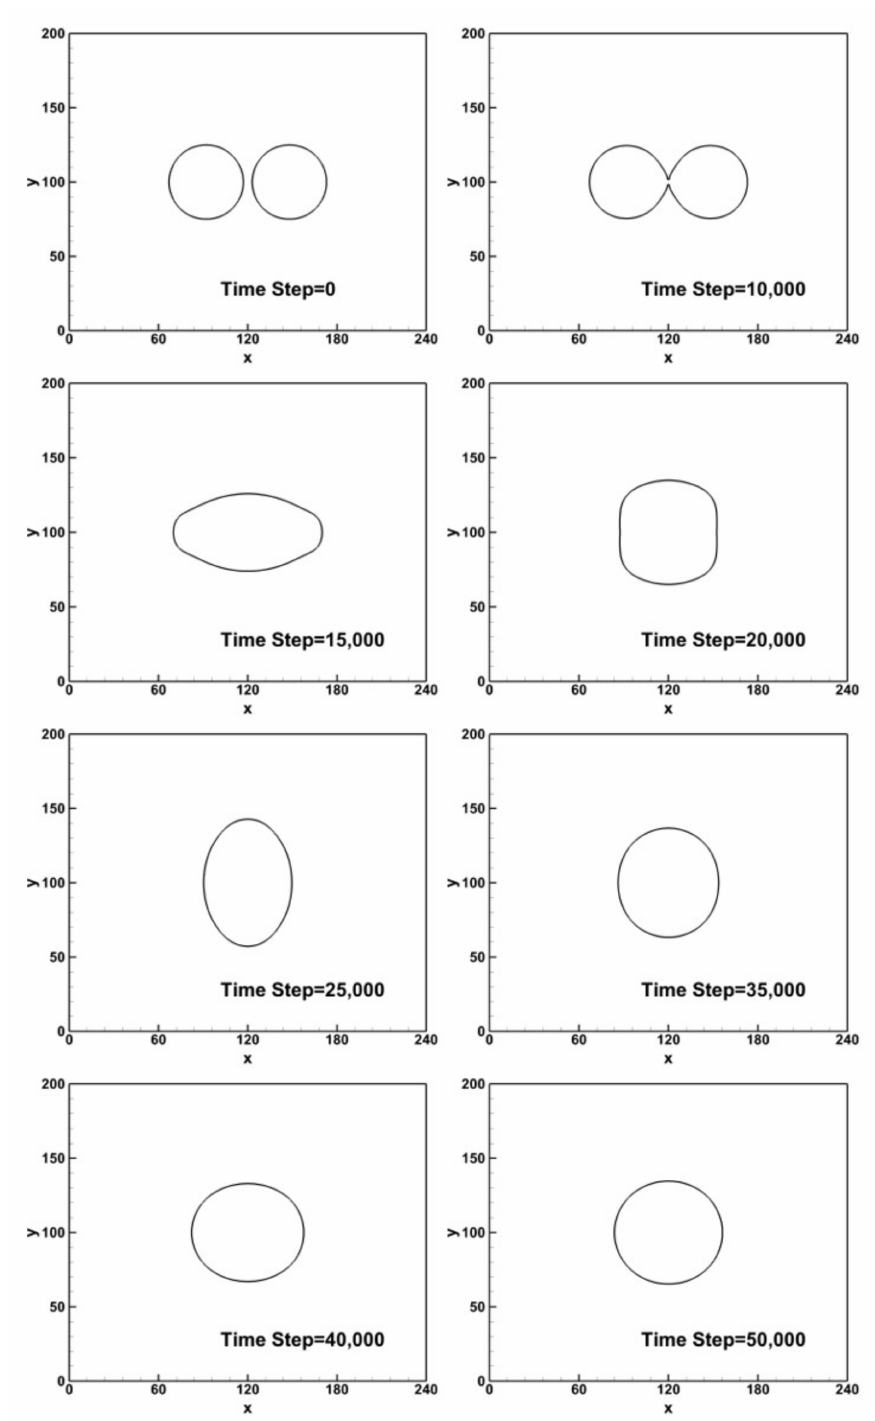
Figure 13. Development of the interface for bubbles